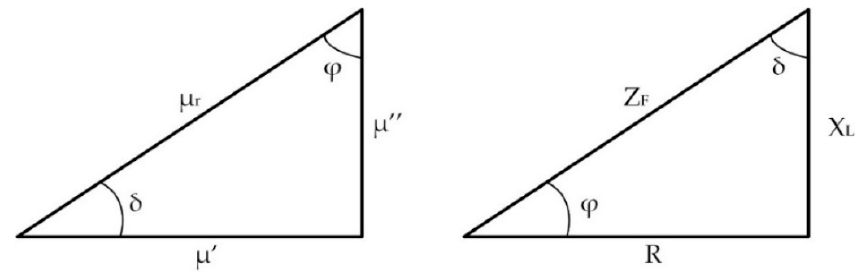
Figure 4. Vector relationship between µ (cid:3045) , µ (cid:4593)(cid:4593) , and µ (cid:4593)(cid:4593) ( left ); vector relationship between Z F , R and X L (2 π fL) ( right ).